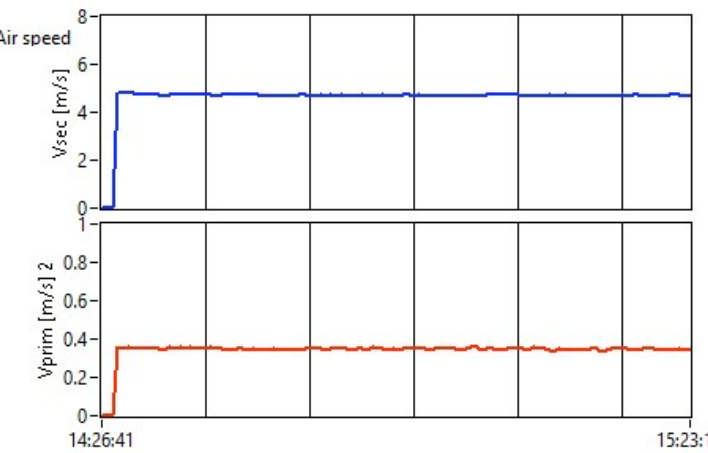
Figure 14. Evolution of primary and secondary air speed with a ratio of 1/3 and a flow rate of 25/65 L/min, during the test.